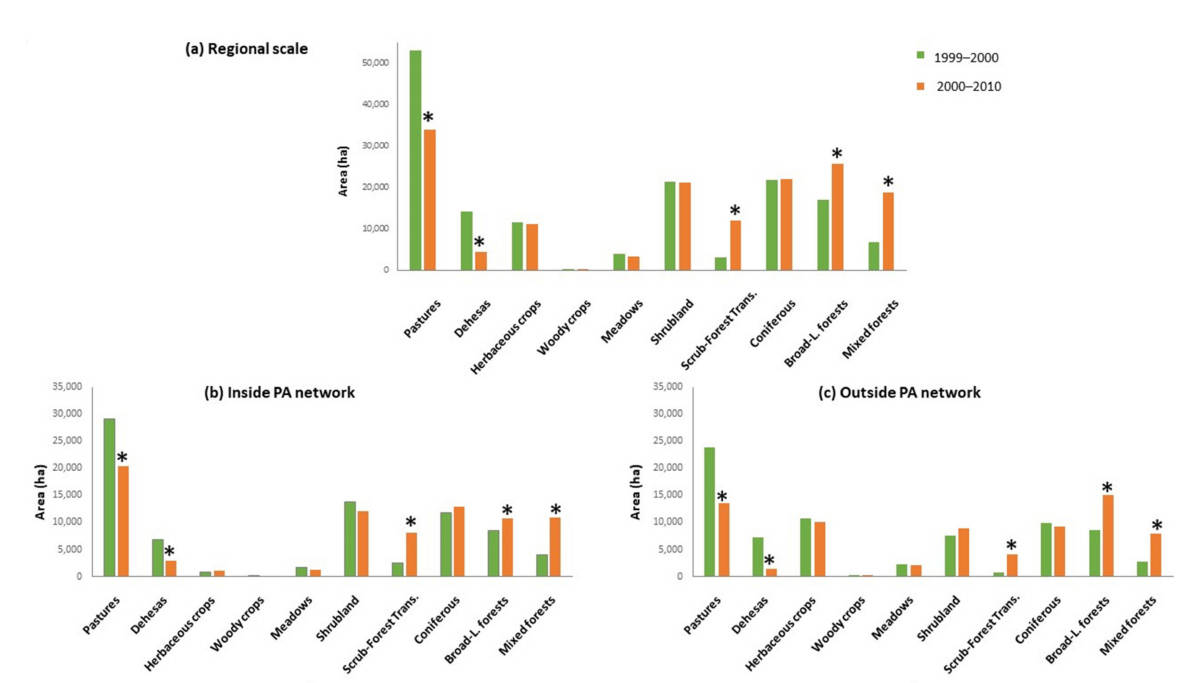
Figure 4. Temporal evolution of the land use descriptors of HNVF in the PA network and their surrounding area: ( a ) at a regional scale (study area); ( b ) inside of and ( c ) outside of the PA boundaries. Statistically significant changes ( p < 0.05) analysed by means of Student’s t test are indicated with an asterisk.